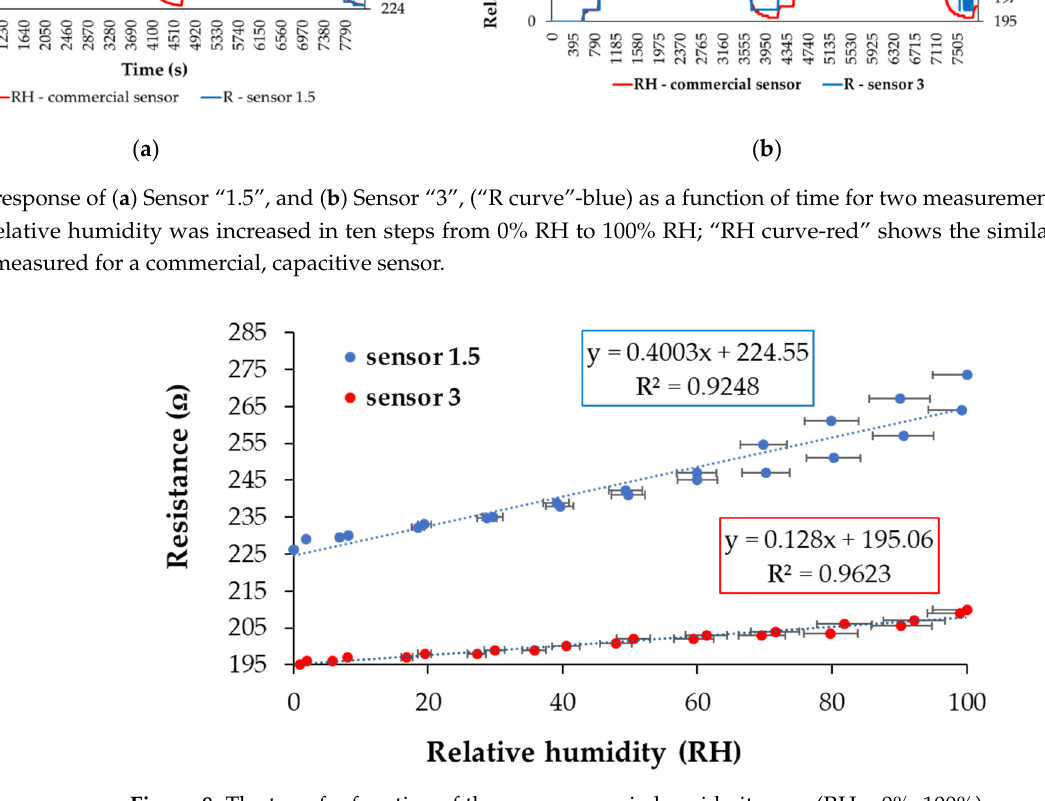
Figure 8. The transfer function of the new sensors in humid nitrogen (RH =